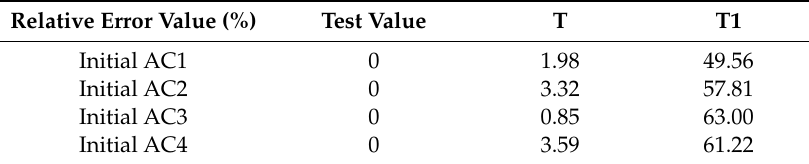
Table 9. The Voidage Value’s Calculated Relative Error.